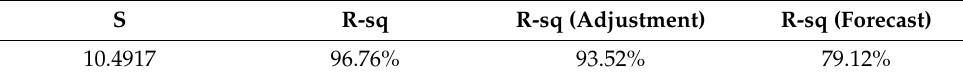
Table 7. Model summary table.